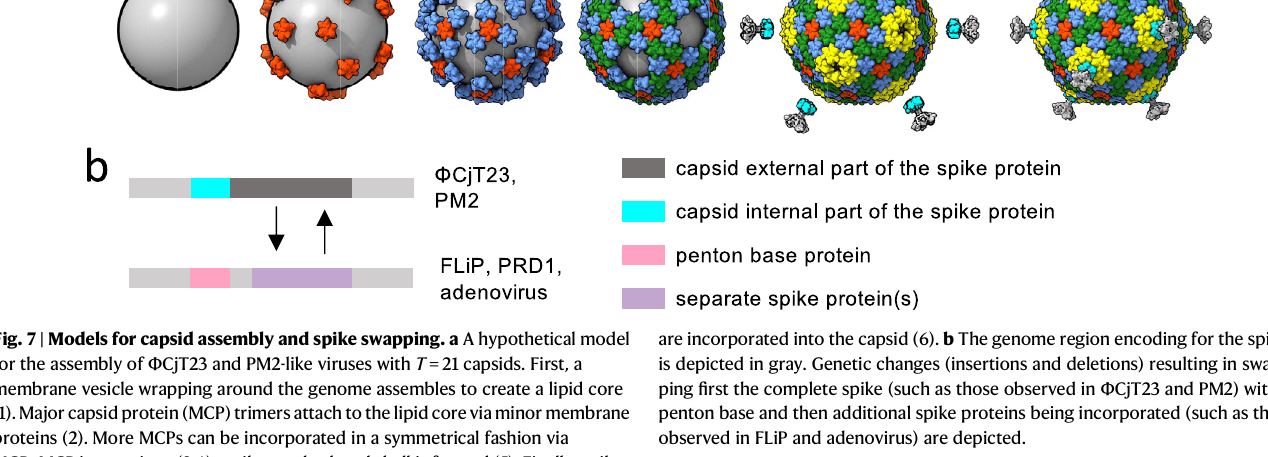
Fig. 7 | Models for capsid assembly and spike swapping. a A hypothetical model for the assembly of Φ CjT23 and PM2-like viruses with T =21 capsids. First, a membrane vesicle wrapping around the genome assembles to create a lipid core (1).Majorcapsidprotein(MCP)trimersattachtothelipidcoreviaminormembrane proteins (2). More MCPs can be incorporated in a symmetrical fashion via MCP – MCP interactions (3,4)untila nearlyclosed shell isformed(5).Finally, spikes